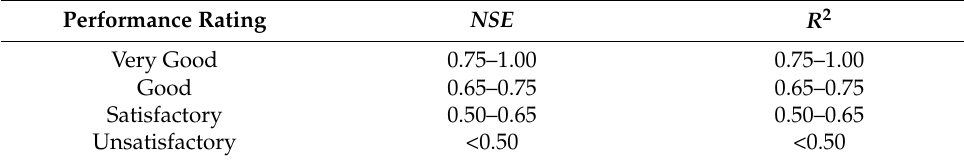
Table 3. Model performance evaluation criteria